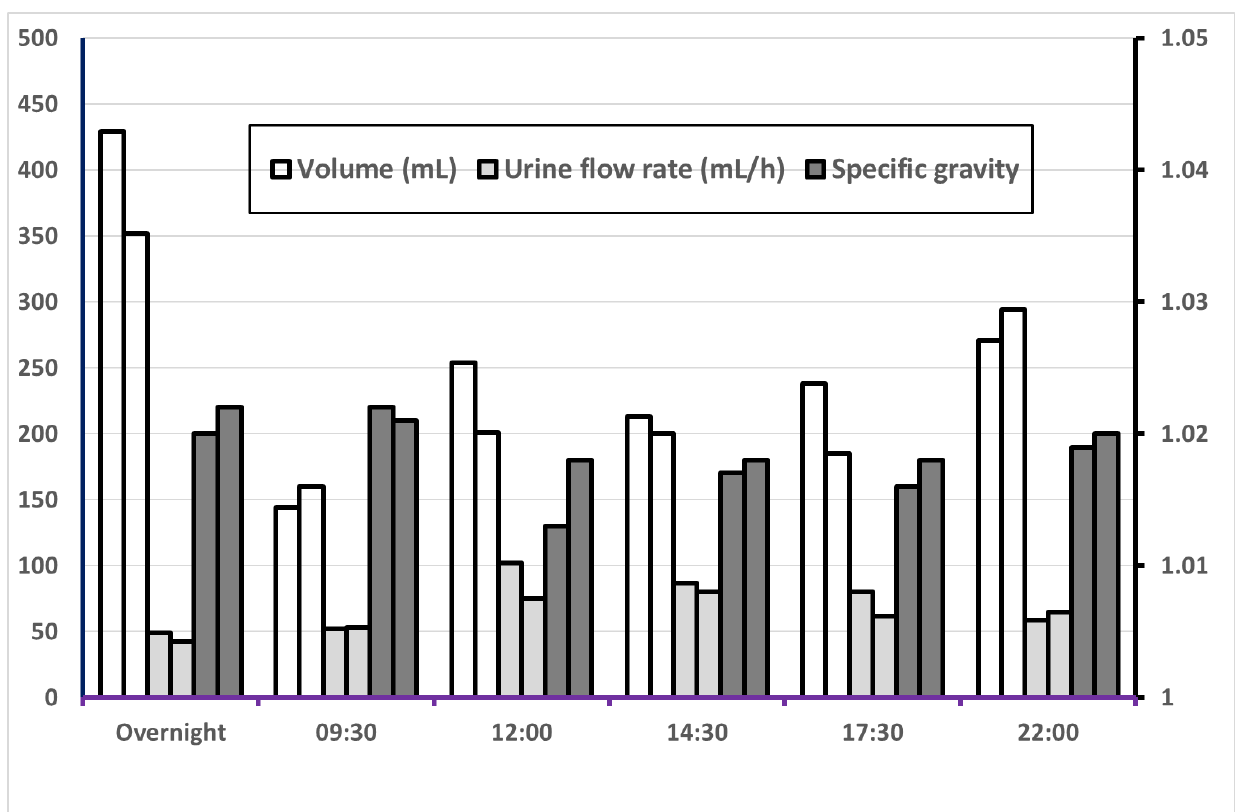
Figure 1. Median values of volume, urinary flow rate and specific gravity (on the right axis) for 60 subjects in each of two 24 h sampling periods. For each measure, the left bar represents Day 1 and the right bar Day 2.